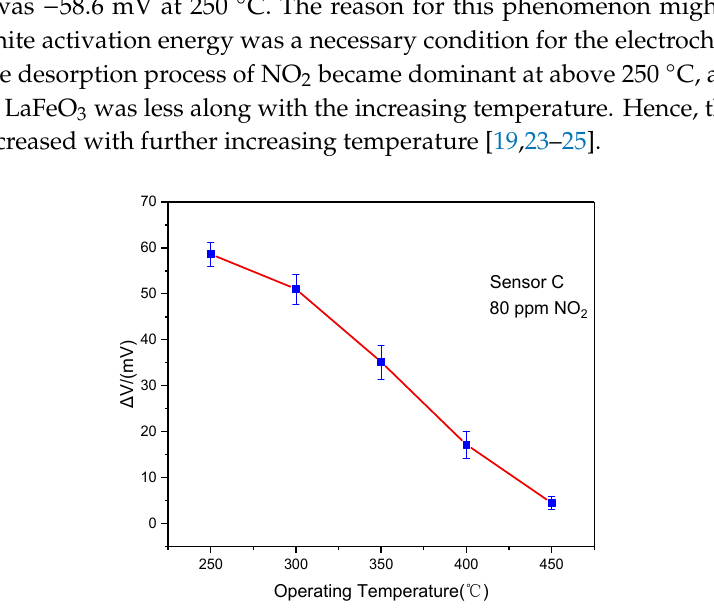
Figure 4. Response changes of the sensor to 80 ppm NO 2 at a di ff erent operating temperature.